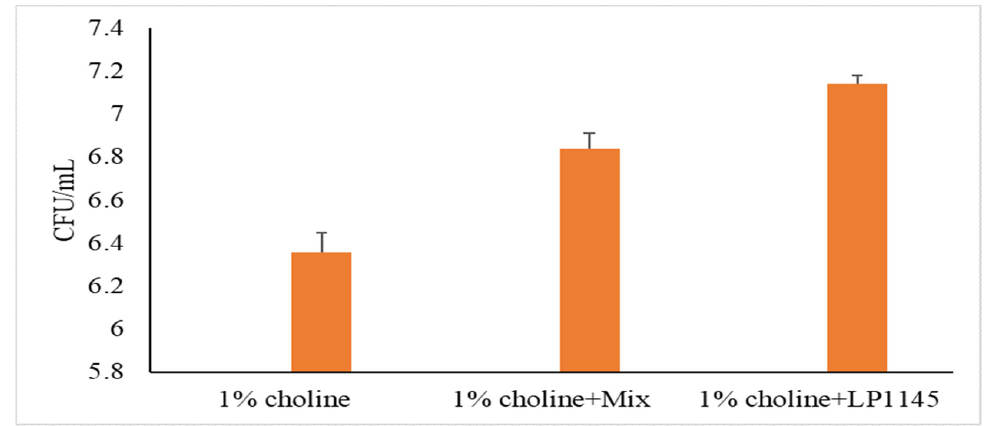
Figure 4. Total lactobacilli counts in mice cecum. Experimental conditions were as described in Methods. Values are shown in mean value ± SD ( n = 7).